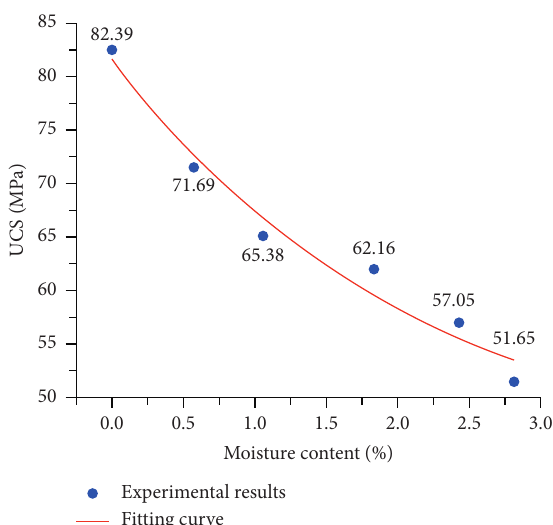
Figure 5: Relationship between UCS and ω .